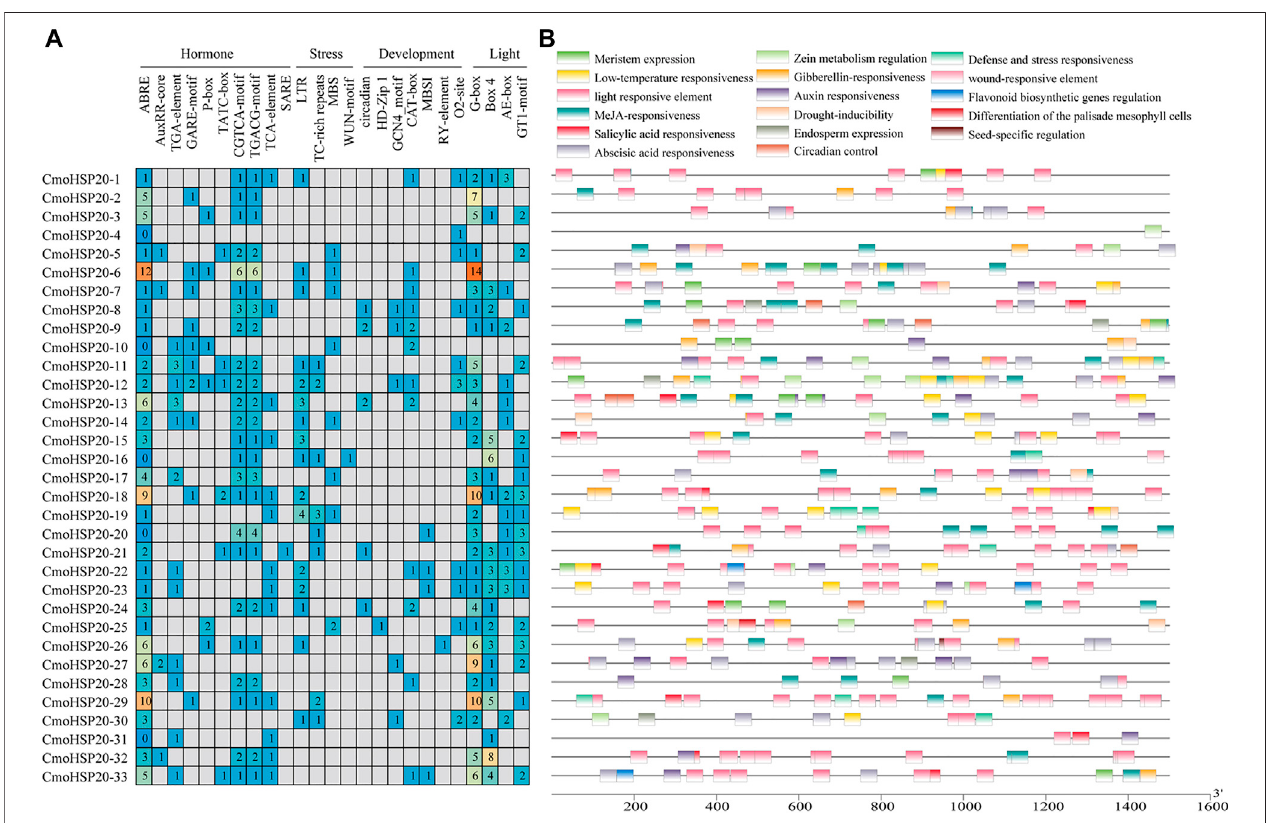
FIGURE 7 | Cis -elements analysis of the CmoHSP20 genes promoter regions. (A) The different colors and numbers indicated the numbers of different promoter elements in the CmoHSP20 genes. (B) Colored blocks represent the different types of cis -elements and their locations in each CmoHSP20 gene. The types, numbers, and locations of potential elements in the promoter regions 1.5-kb upstream of the CmoHSP20 genes were determined using PlantCARE